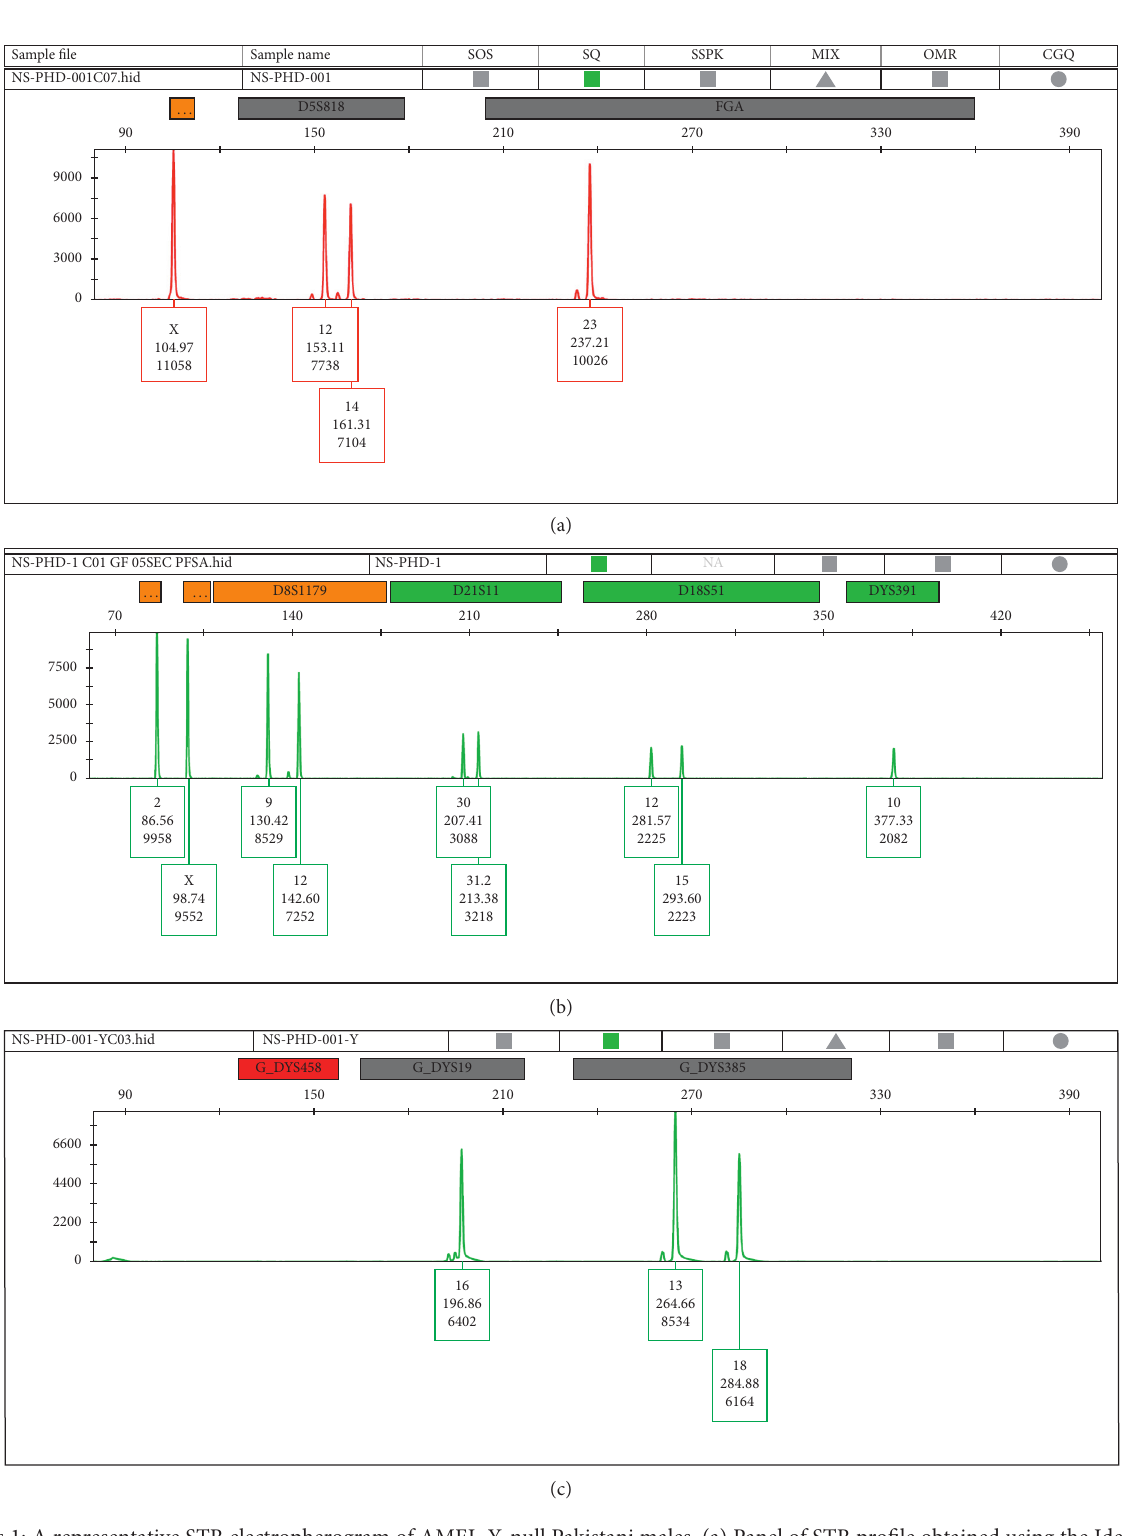
Figure 1: A representative STR electropherogram of AMEL-Y-null Pakistani males. (a) Panel of STR profile obtained using the Identifiler Plus STR system showing the absence of Amel-Y. (b) Panel of STR profile obtained using the Global Filer STR system showing the absence of Amel-Y. (c) Panel of haplotype profile obtained using the Y-filer STR system showing the absence of